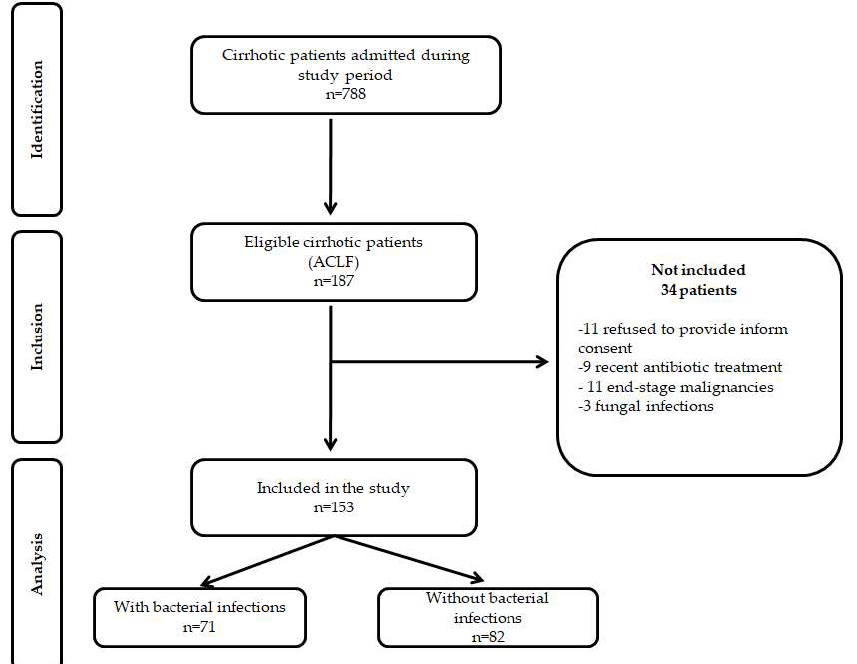
Figure 1. STROBE flow diagram of patients included and excluded from the study